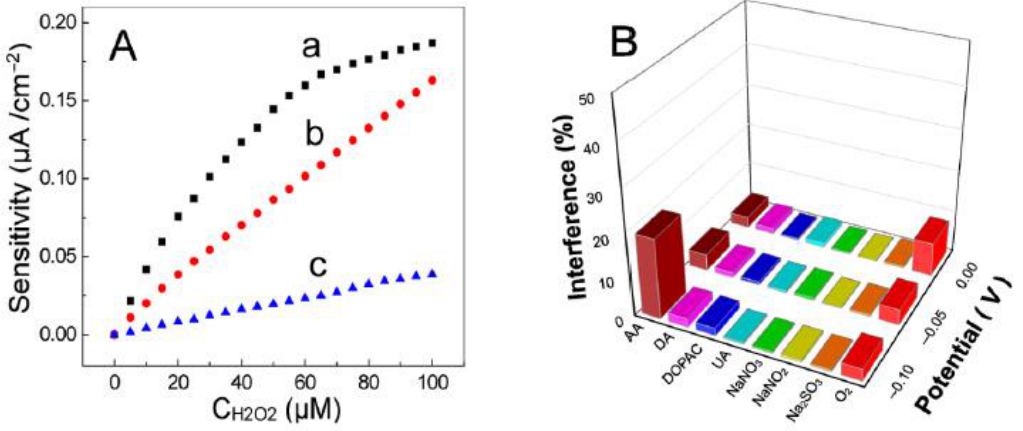
Figure 3. Effect of the working potential on the response of a cytochrome c -based H 2 O 2 biosensor. ( A ) Biosensor calibration plots obtained at (a) 22120.10, (b) − 0.05, and (c) 0.00 V vs. Ag/AgCl. ( B ) Response to interfering compounds at the different working potentials. Upon lowering the potential, the sensitivity of the device is increased and the selectivity is decreased (i.e., interference from AA, DA, and DOPAC is increased). AA—ascorbic acid, DA—dopamine, DOPAC—dihydroxyphenylacetic acid, UA—uric acid. Adapted with permission from Zhou et al. [50]. Copyright (2014) American Chemical Society.